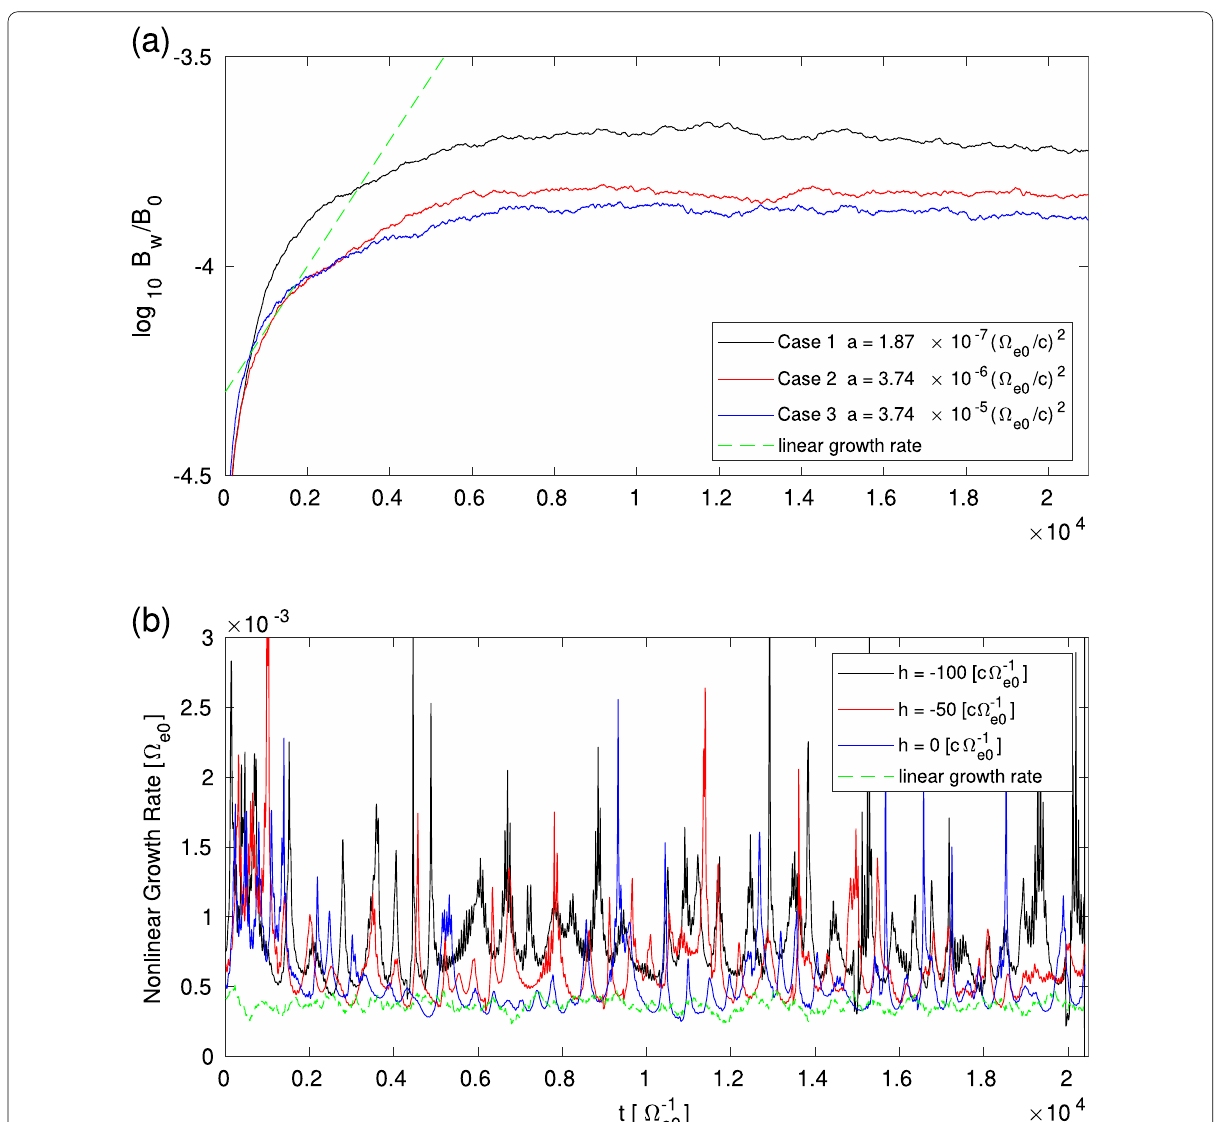
Fig. 6 a Averaged wave amplitudes of forward-propagating waves in the entire simulation region, and the linear growth rate; b nonlinear growth rates at h = − 100, − 50 and 0 [ c (cid:31) − 1 e 0 ] , and the linear growth rate within the time period of t = 0 ∼ 2.04 × 10 4 [ (cid:31) − 1 e 0 ] in Case